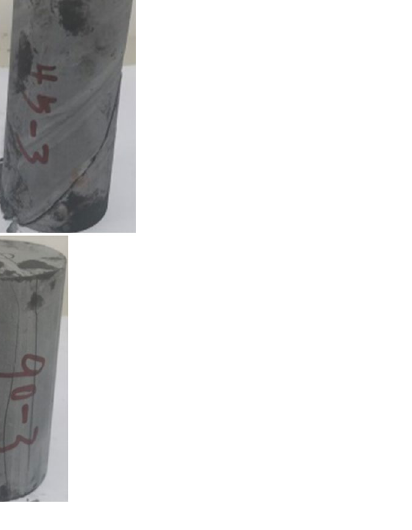
Figure 7. Macroscopic destruction picture of